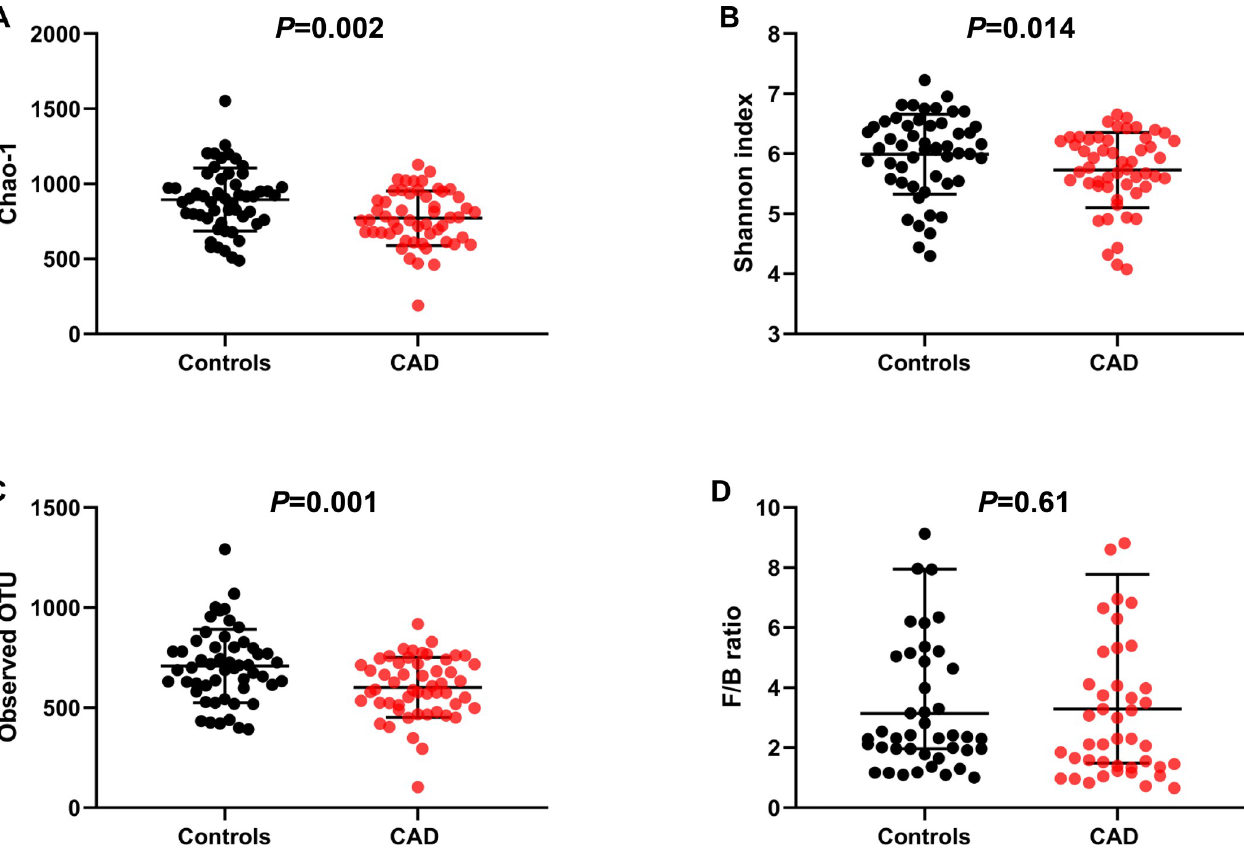
Fig 2. Gut microbial change in patients with or without advanced CAD. ( A) Chao-1. (B) Shannon-index. (C) Observed OTU. (D) The ratio of Fermicutes to Bacteroidetes